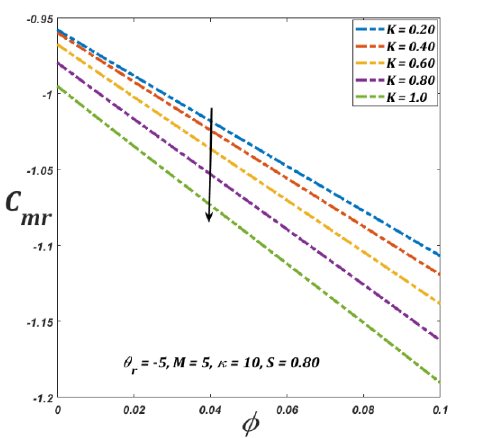
Figure 8. ( a ) Skin friction Coefficient with Micropolar parameter. ( b ). Skin friction coeffiecient with curvature parameter. ( c ). Skin friction coefficient with variable viscosity parameter. ( d ). Skin friction with porosity parameter. Processes 2018 , 6 , x FOR PEER REVIEW